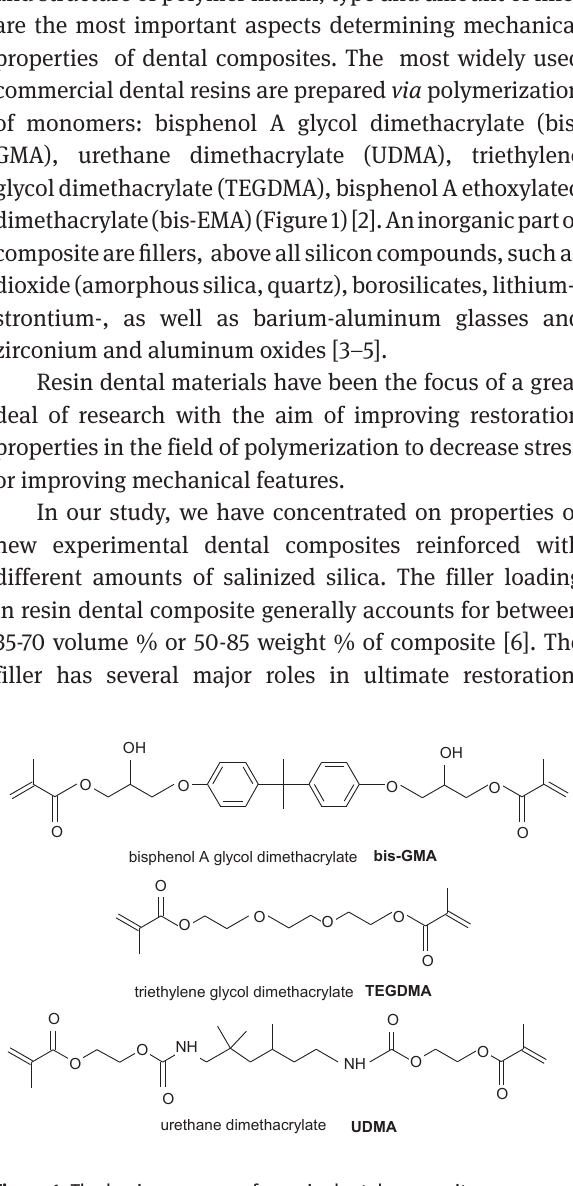
Figure 1: The basic monomers for resin dental composite.